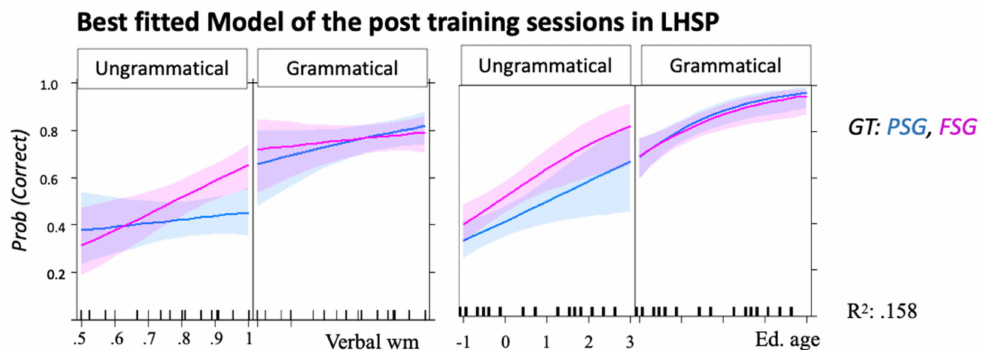
Figure 4. AGL in stroke condition (49 left hemispheric stroke patients, LHSP). Among the eleven possible syntax-internal and -external variables, education was the most significant predictor for grammatical classification accuracy in the post-training sessions: this effect did not interact with any other factors. Grammaticality was the second predictor, and it significantly interacted with grammar type and verbal working memory: the better the verbal WM performance, the better the accuracy of ungrammatical (but not grammatical) FSG (but not PSG) items. Table 3. Fixed effects and their interactions derived from the best-fit model for post-training sessions in